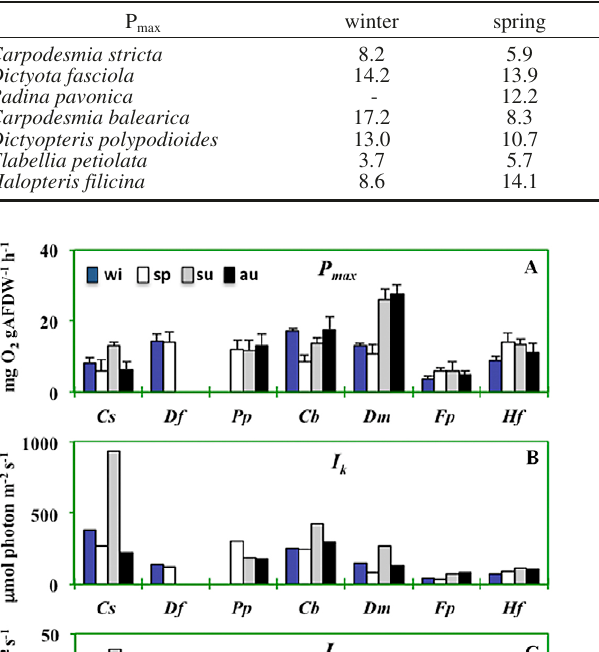
, in mg O gAFDW –1 h –1 ) for species and season. max 2